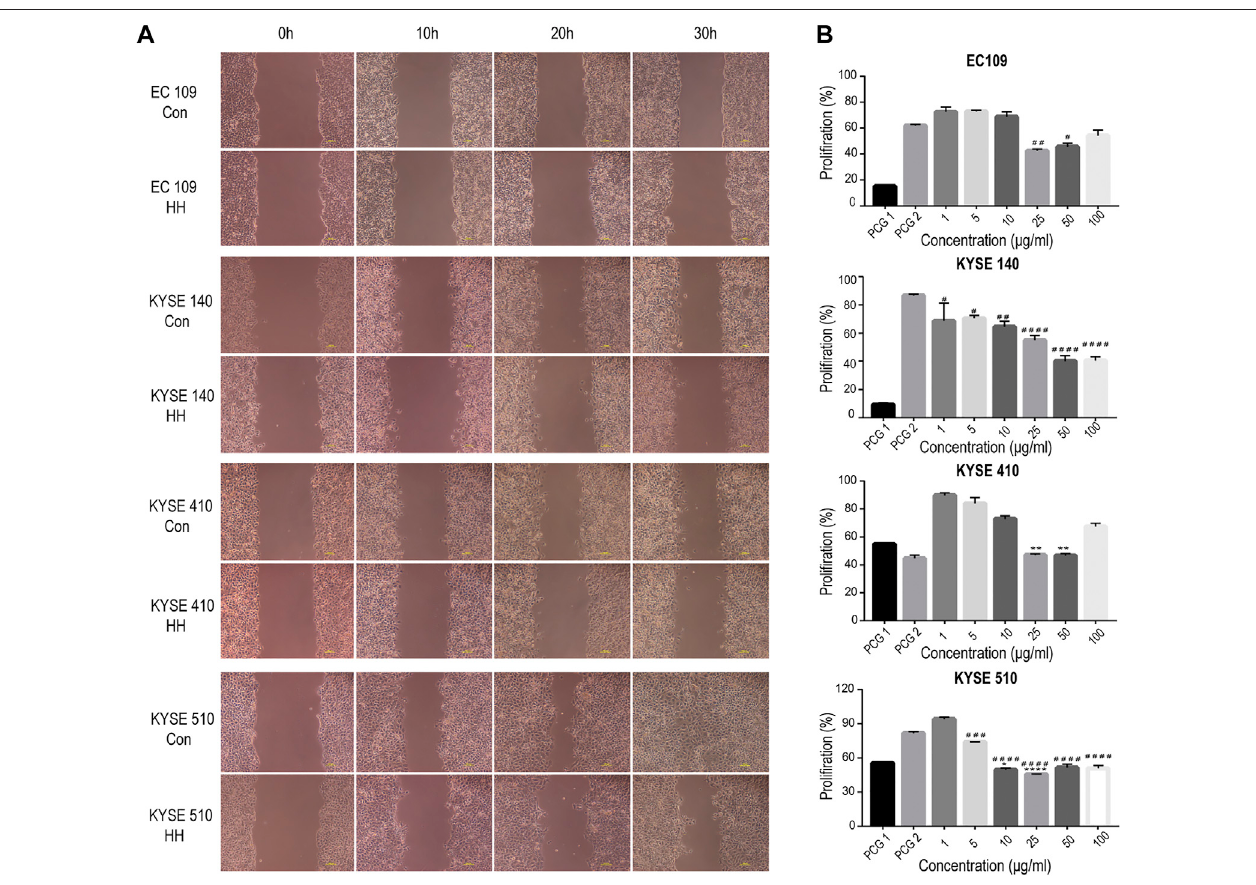
FIGURE 6 | Water extract from OH inhibits migration and growth in the line of the esophageal cancer cell (EC109, KYSE140, KYSE410, and KYSE510). (A) The migrationratewasmeasuredbythewoundhealingassay. (B) ComparisonofdifferentdosesofthewaterextractofOHoncellviabilityusingtheCCK-8assay.Errorbars representSD(standard deviation), *indicatesadifferencecomparedwiththePCG1group. * p < 0.1,** p < 0.01,*** p < 0.001,and **** p < 0.0001. # indicatesadifference compared with the PCG 2 group. # p < 0.1, ## p < 0.01, ### p < 0.001, and #### p < 0.0001.